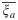
The mean total active fraction ξa¯ versus R0 is independent of ℓ; a manifestation of perfect adaptation as predicted by BL model.The figures show the results for two values of A0, 5.3μM (a) and 13.6μM (b). In both the figures, the insets show the corresponding variances. Note that the maximum of the variance occurs at the same R0 for various ℓ.